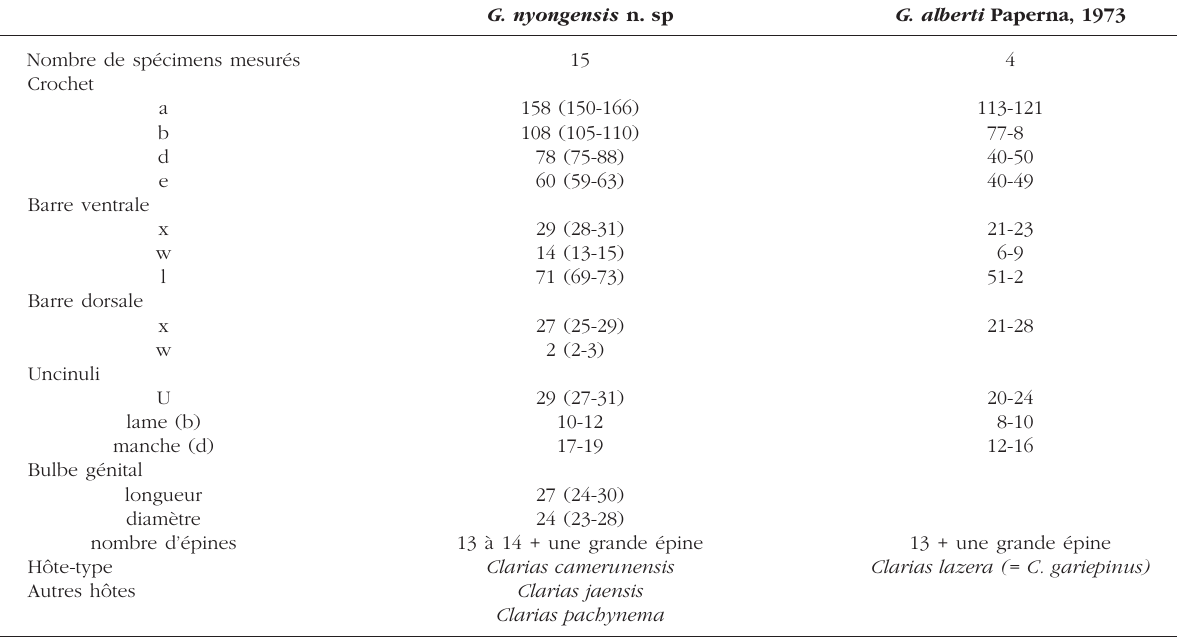
Tableau II. – Comparaison des données morphométriques de Gyrodactylus nyongensis n. sp. avec celles de Gyrodactylus alberti Paperna,